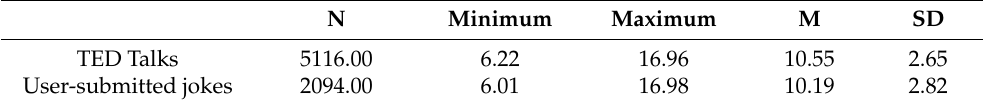
Table 3. Summary of statistics for readability scores using the Gunning Fog Index.